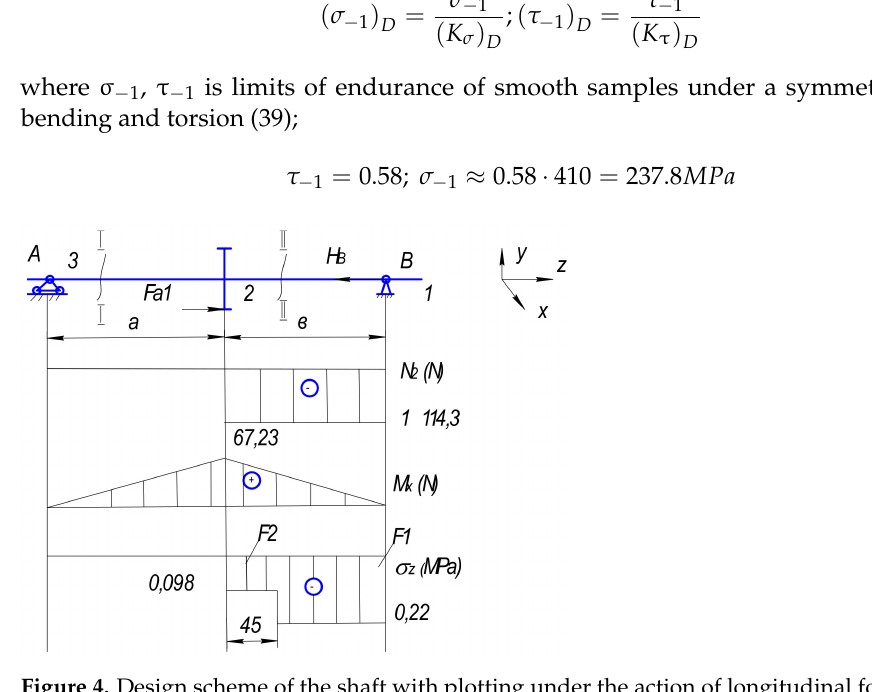
Figure 4. Design scheme of the shaft with plotting under the action of longitudinal forces: I, II are shaft sections; x, y, z are coordinate systems of axes; a, b are distances between bearings; A, B are designations of bearings on the shaft; 1, 2, 3 are shaft sections; Fog is the cantilever force from the belt drive; Fa1 is the direction of forces on the gear and on the wheel; FB is the direction of force; F1, F2 is cross-sectional area; N2 is longitudinal force; Mx is bending moment; σ z is the stress in the corresponding shaft section.